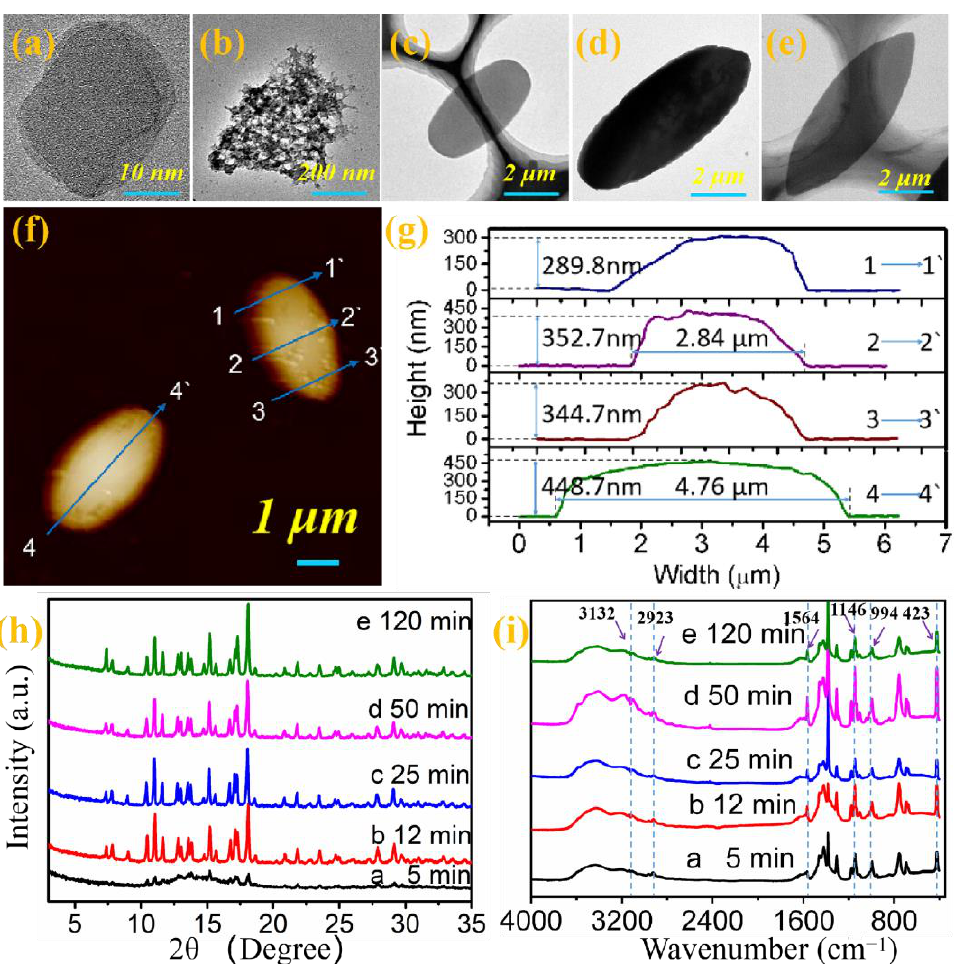
Figure 1. The morphology transformations with the reaction time ( a ) 5 min, ( b ) 12 min, ( c ) 25 min, ( d ) 50 min, ( e ) 120 min, ( f ) SPM image of ZIF-L ( g ) basic parameters of ZIF-L by SPM, ( h ) XRD patterns dependent on the reaction time, ( i ) FT-IR spectrum dependent on the reaction time.